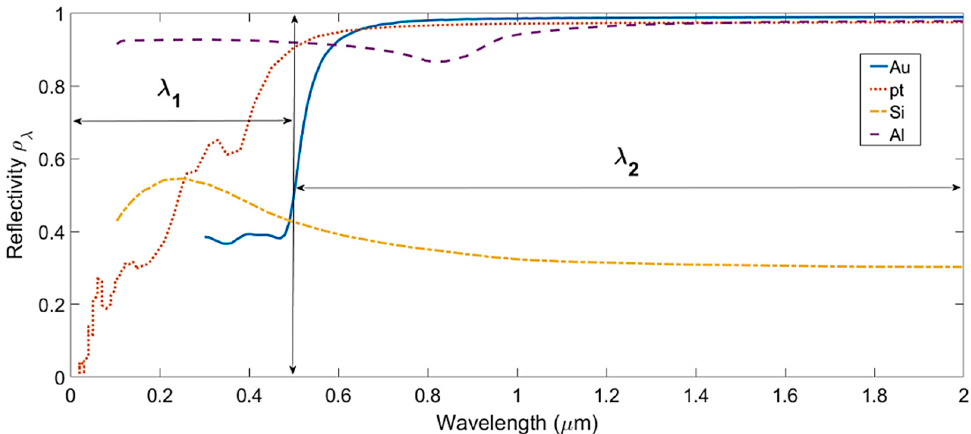
Figure 6. Unpolarized reflectivity versus wavelength for several conductors and dielectric materials calculated for normal incidence.